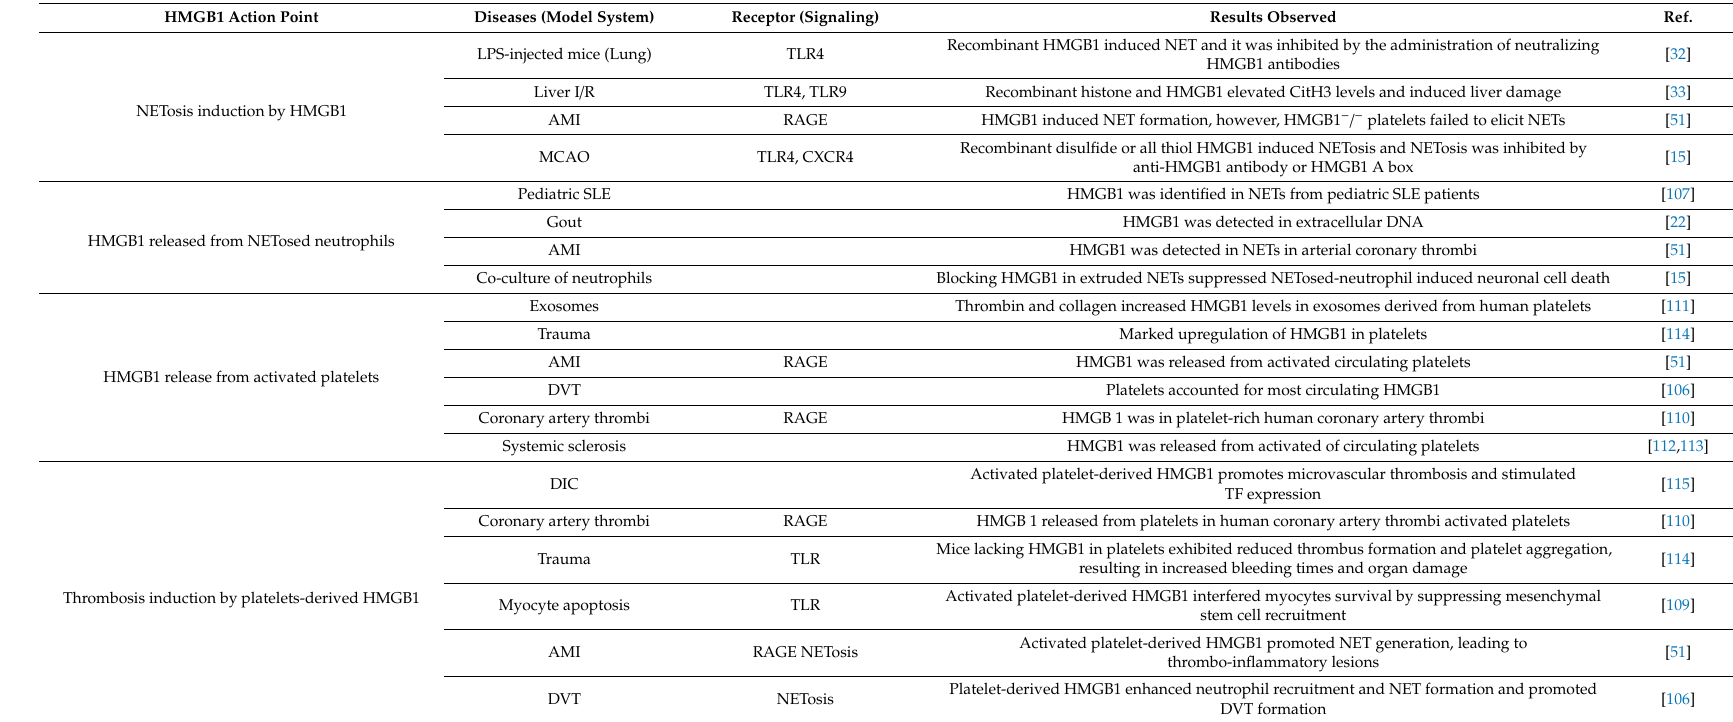
Table 2. HMGB1 in the interplay between